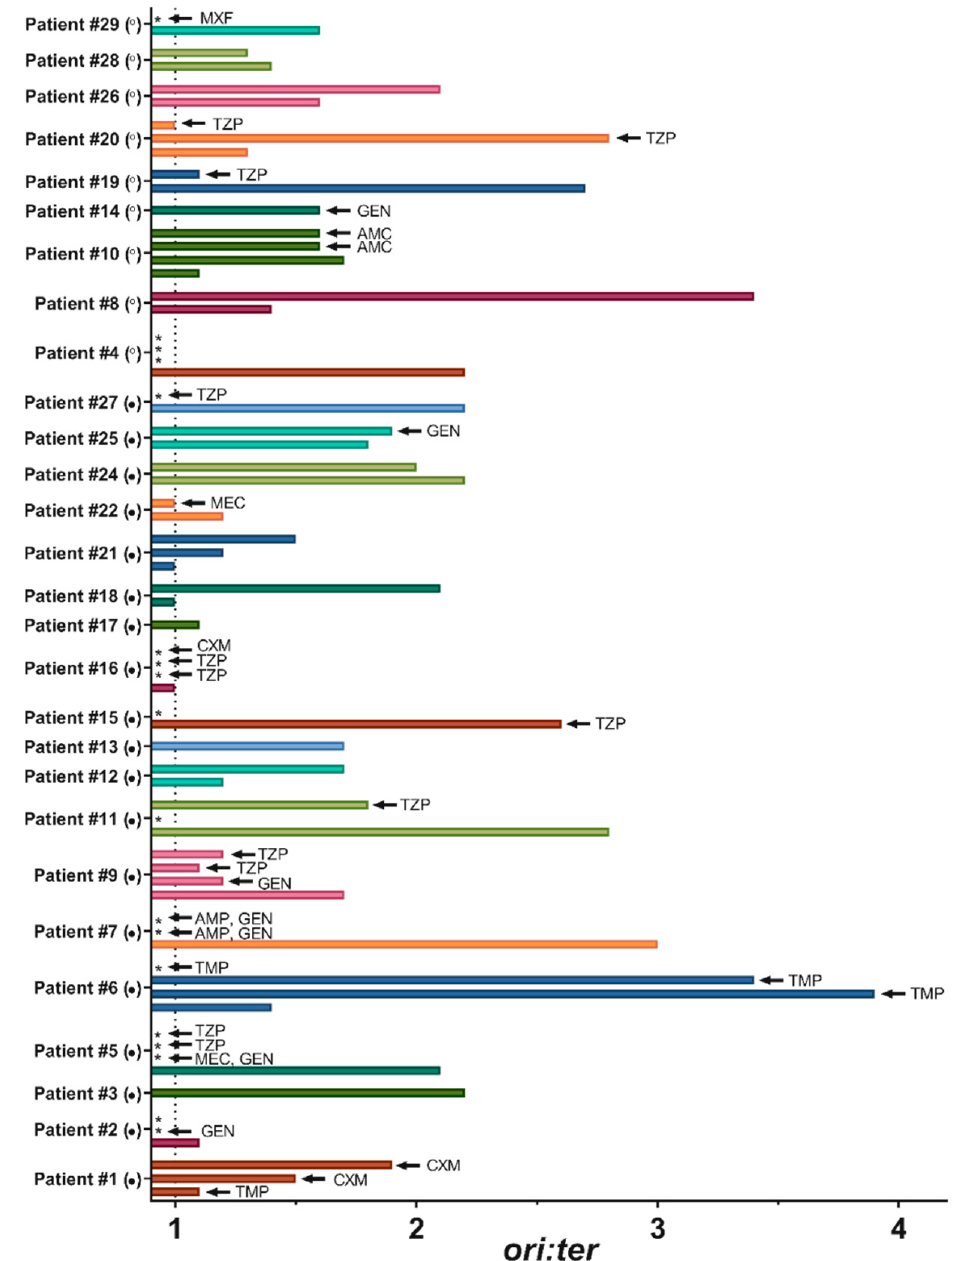
Figure 1. Distributions of ori:ter in the study population. Each bar represents the mean ori copy number of technical triplicates relative to the mean ter copy number of technical triplicates analyzed from one urine sample. For every patient, the lower bar represents the day 0 urine sample, and the follow-up urine samples (day 1 up to day 3) are presented in upwardly directed chronological order. Urine samples not yielding adequate copy numbers for quantification are represented by an asterisk. The arrow indicates that antibiotic treatment (any relevant) had been given at the time of urine sampling. No relevant antibiotic treatment had been given at the time of urine sampling. The closed circle indicates that the patient was classified as having UTI. The open circle indicates that the patient was classified as not having UTI. The dotted line represents the minimum possible ori:ter level (i.e., no growth). Patient no. 23 is not included, as no ori:ter was available. AMC: amoxicillin-clavulanic